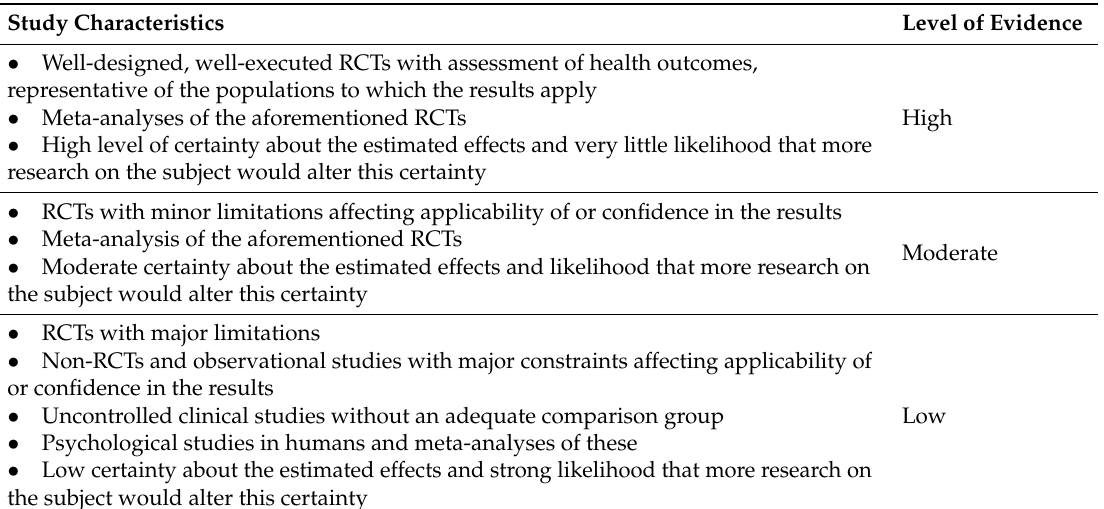
Table 3. Levels of scientific